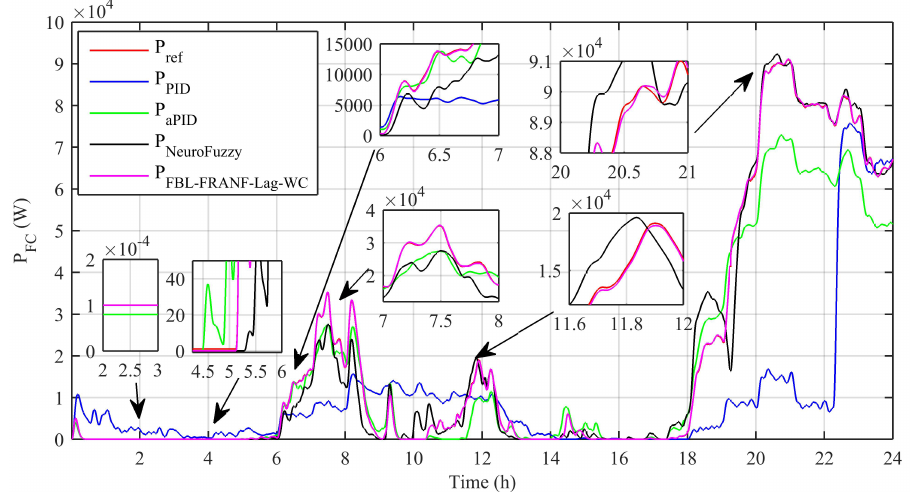
Figure 7. Output power of the SOFC.